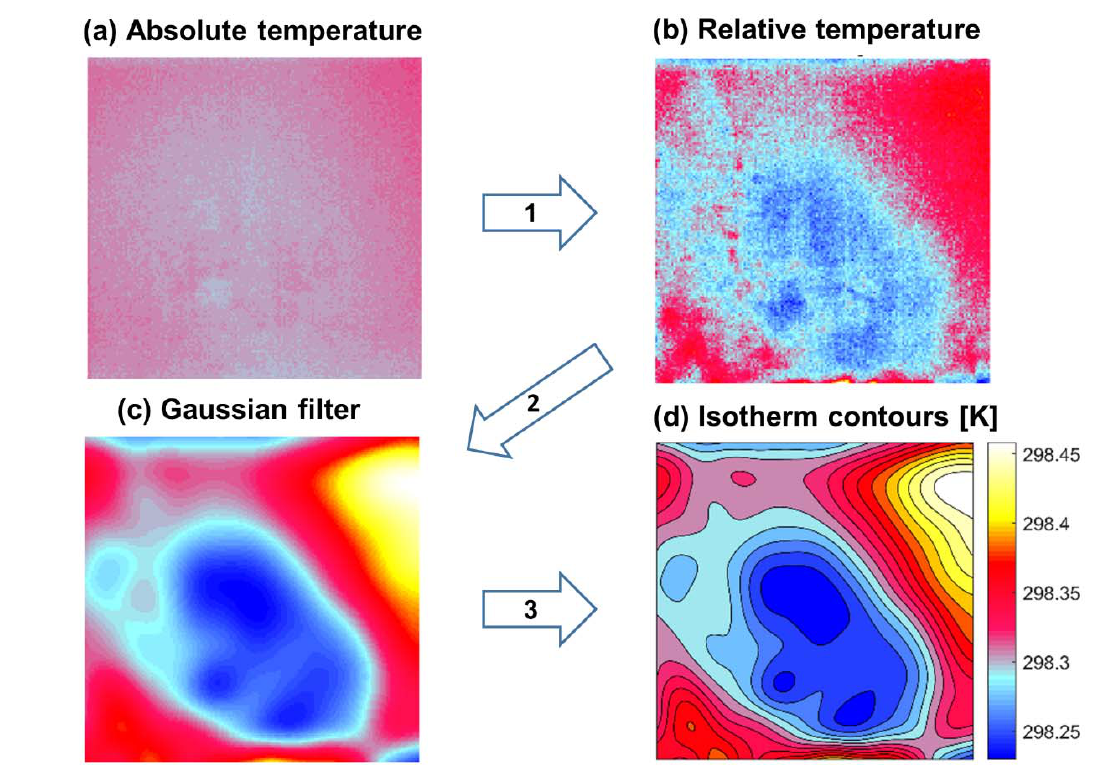
Figure 4: Thermal image processing steps: a) absolute temperature detected by IR camera; b) the ambient temperature is subtracted; c) noise reduction by means of a Gaussian filter (SD=8); d) the isotherm contours are plotted.